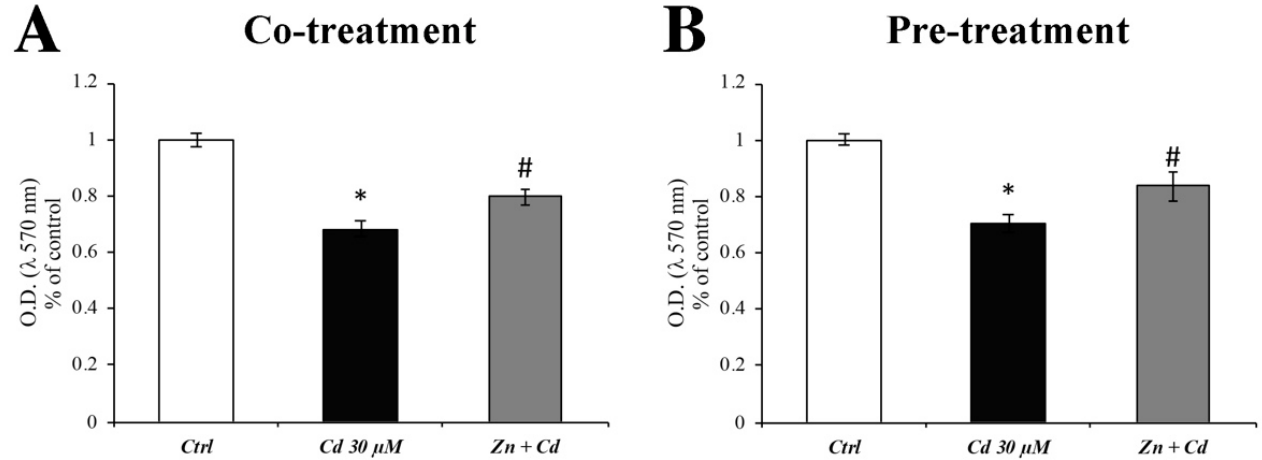
Figure 1. RBE4 cell viability after CdCl 2 and ZnCl 2 exposure. The histograms clearly show that CdCl 2 treatment significantly decreased RBE4 cell viability (black column). This result was counter- acted when RBE4 cells were treated with ZnCl 2 50 µM (grey columns), which prevented the decrease in cell viability by about 20%, both during cotreatment ( A ) and 24 h pretreatment ( B ) regimens. Results are expressed as mean ± SEM, and control (untreated cells) was arbitrarily taken as 100%. Experiments were performed in quintuplicate for three different sets of experiments. * p < 0.05 vs. Ctrl; # p < 0.05 vs. Cd treatment.